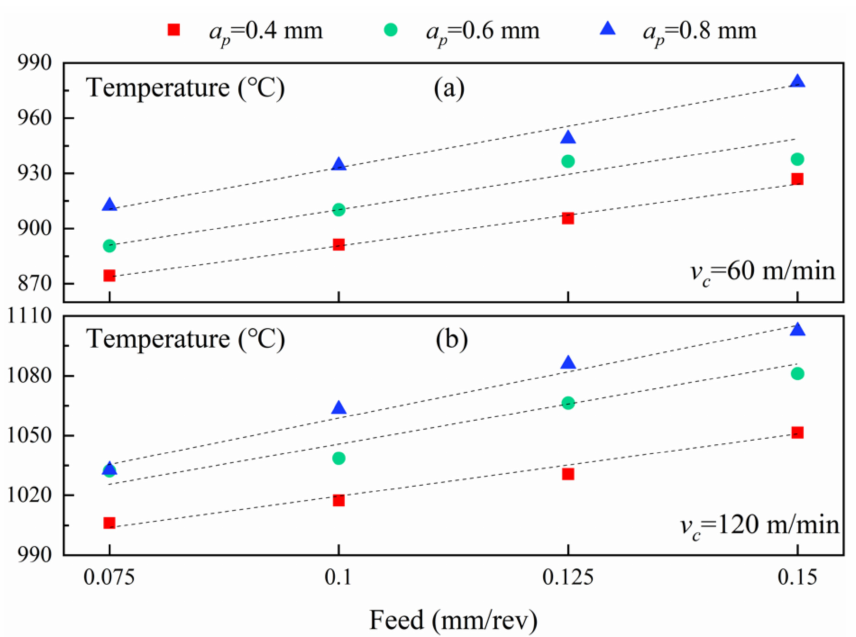
Figure 9. ( a ) The variations of the cutting temperatures as feeds and cutting depths at 60 m/min. ( b ) The variations of the cutting temperature as feeds and cutting depths at 120